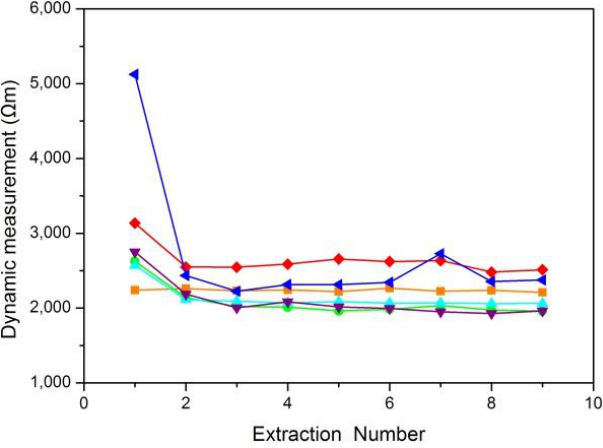
Figure 6. Results of six dynamic skin resistance measurements. The time interval between each two measurement results was over 10